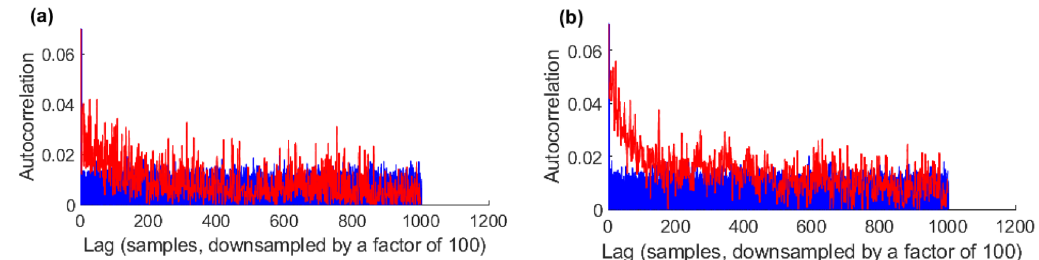
Figure 2. Plots demonstrating examples of the intra-scale autocorrelation of non-stationary pre-whitened neural signals vs. that of stationary white noise. Red shows the intra-scale autocorrelation function of neural data, Session 1, Chan. 1. Blue represents the intra-scale autocorrelation functions of 100 white noise processes of the same length as the neural recording. ( a ) Scale 20, i.e. a central frequency of 1.6 kHz. ( b ) Scale 40, i.e. a central frequency of 570